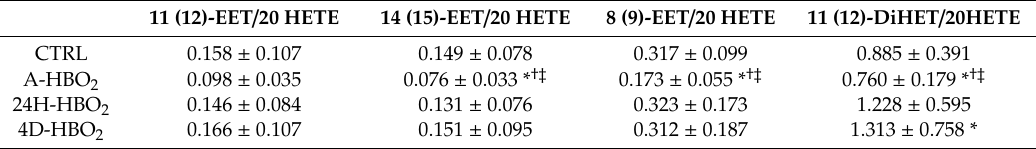
Table 4. Ratios of vasodilatory to vasoconstrictory CYP450 AA metabolites in aortic tissue. 11 (12)-EET / 20 HETE